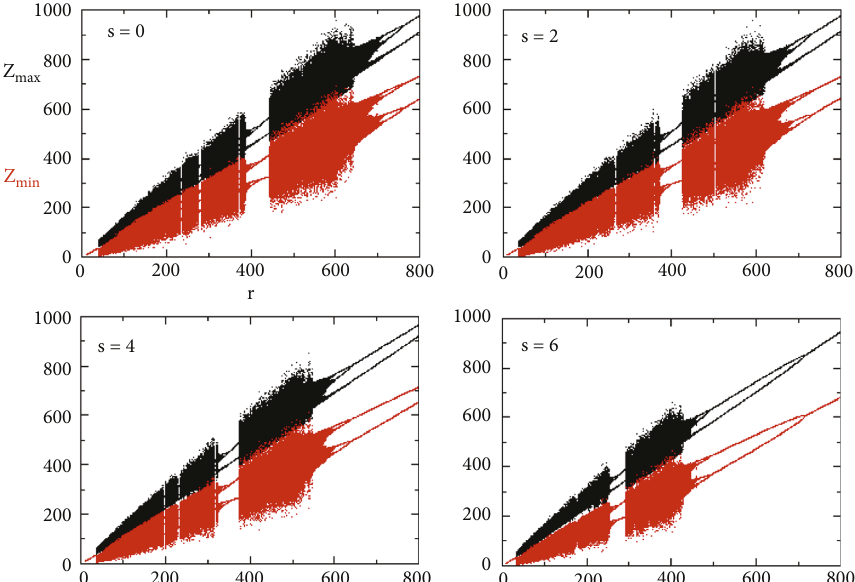
Figure 5: Diagrams of bifurcations of Z as a function of r showing the effect of the helical force on the chaos domain of the system when Λ � 1 Da � 0 . 09, Ta � 0, P � 10, L � M